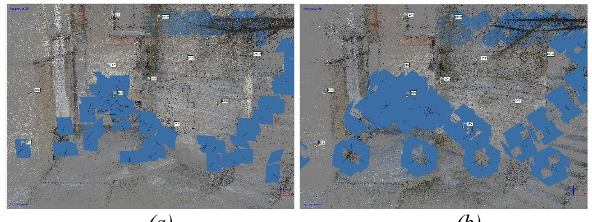
Figure 3. Part of the images network acquired on the calibration field. One of the six camera (a) and the six cameras mounted on the 360 rig (b).